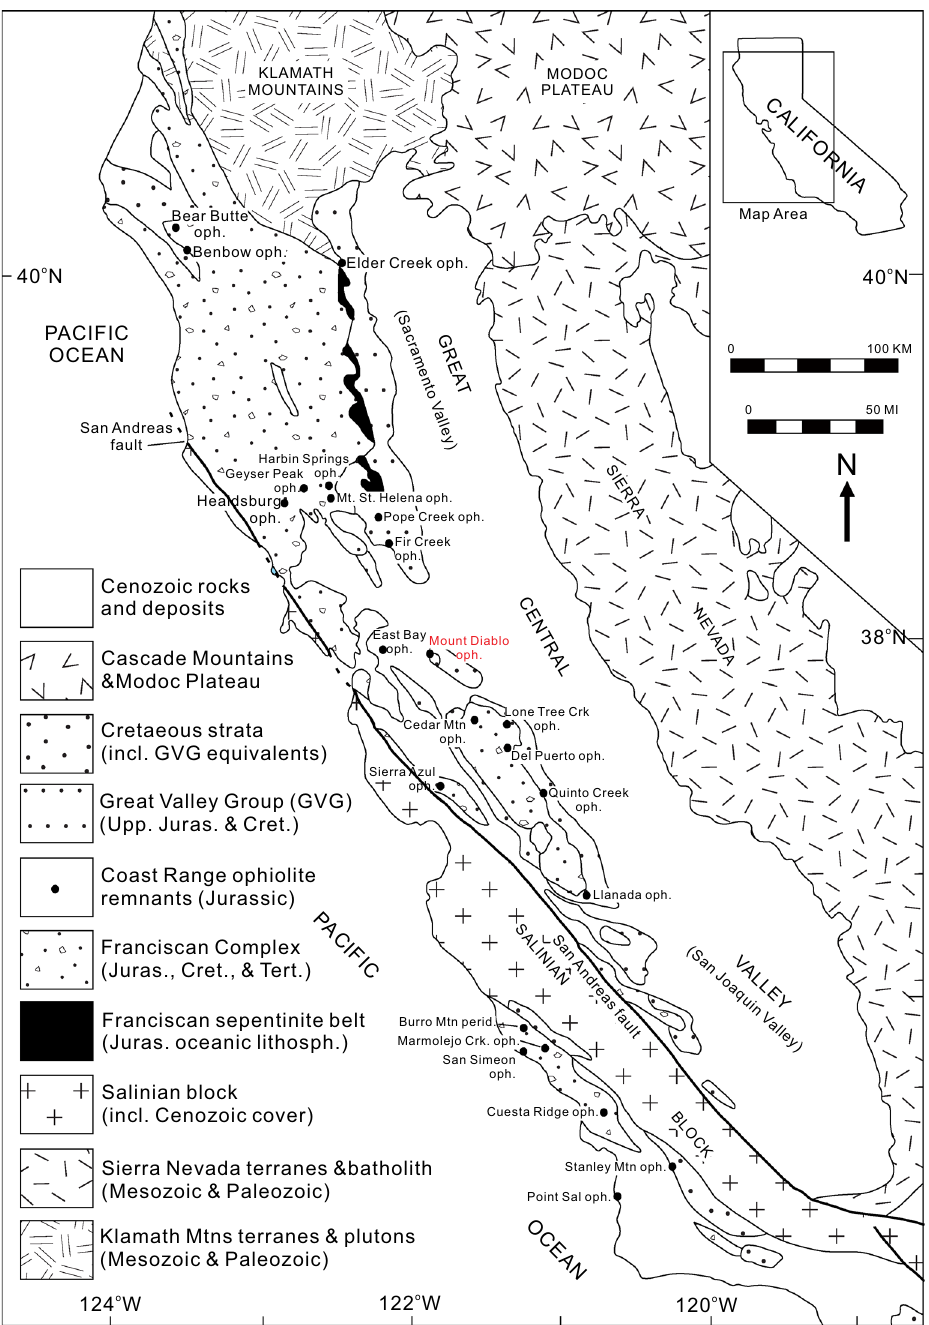
Figure 7. Simplified geological map of western California showing the locations and ages of the Middle to Late Jurassic and Coastal Range ophiolites 116